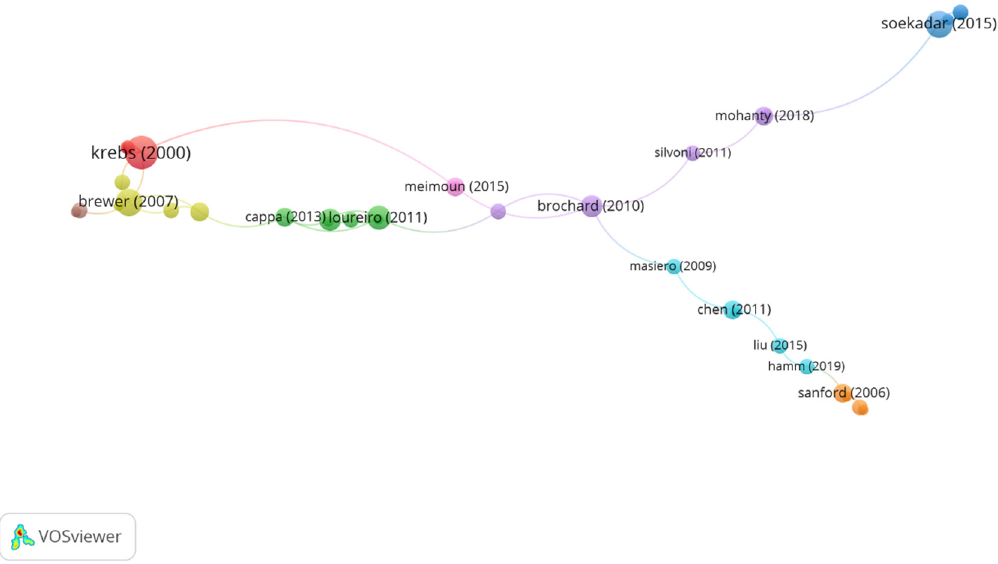
Figure 4. Group 1 citation network. The most cited publication is that of Krebs.